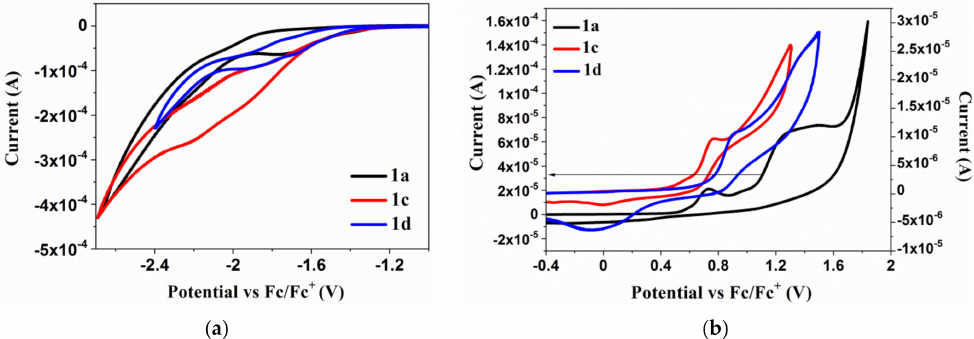
Figure 3. The voltammograms of the ( a ) reduction and ( b ) oxidation processes of the 1a, 1c, 1d (Pt, v = 0.1V/s, 0.1 mol/dm 3 Bu 4 NPF 6 in CH 2 Cl 2 with 10 − 3 mol/dm 3 of compounds).